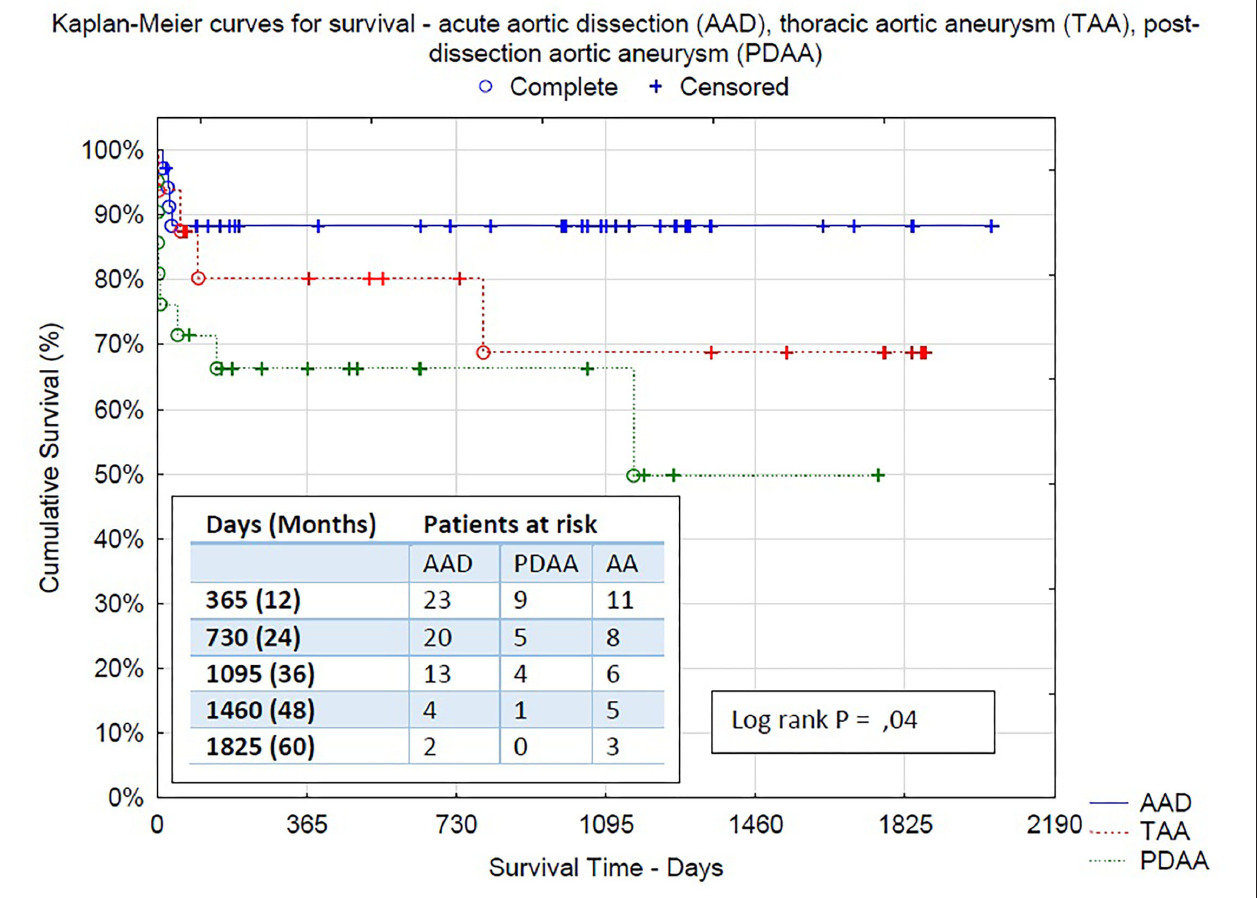
FIGURE 4 | Kaplan–Meier survival curves between all three groups: acute aortic dissection (AAD), thoracic aortic aneurysm (TAA), post-dissection aortic aneurysm (PDAA) − 95% CI 1,801.015 (1,585.471–2,018.503), 95% CI 1,390.010 (986.730–1,793.290), 95% CI 1,574.015 (1,374.679–1,773.351),